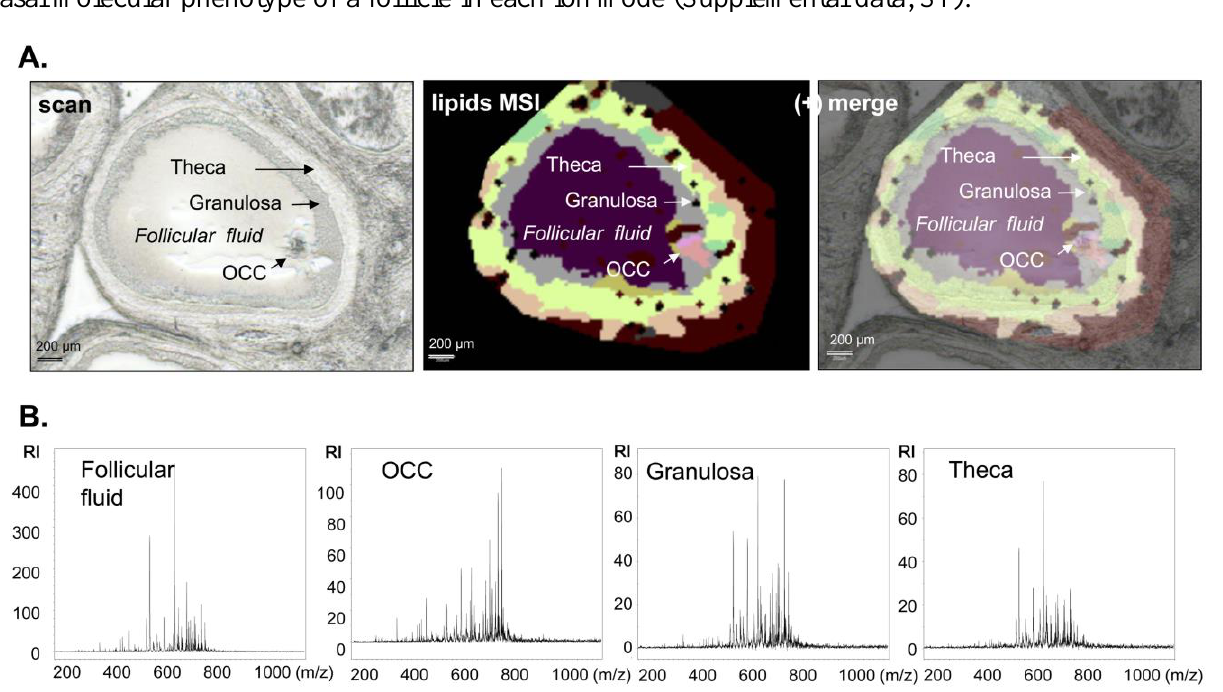
Figure 4. Assessing spatial lipid distribution of the whole follicle from targeted